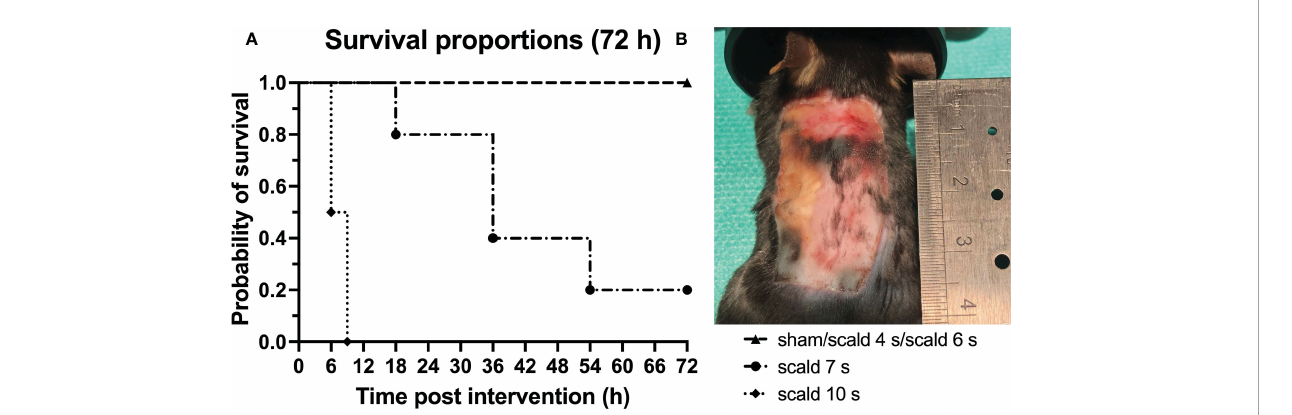
FIGURE 1 Scalding for 7 s or more signi fi cantly decreased the survival rates of mice. (A) : The probability of survival for all study groups up to 72 h after interventions is depicted. Log-rank (Mantel-Cox) test con fi rms a signi fi cant difference between survival curves (p = 0.0095). Note the sharp increase in mortality when mice were scalded for 7 s or more. (B) : Macroscopic fi nding of the wound site of the surviving 7 s scald mouse 72 h after intervention. Note the sharply bounded wound